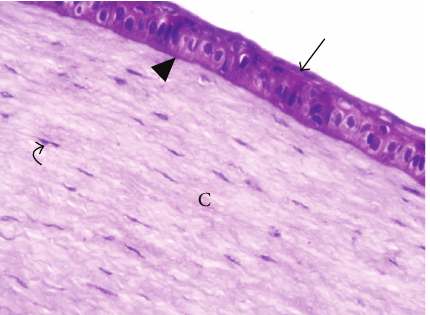
Figure 6: A photomicrograph of rabbit cornea group I, showing the layers of nonkeratinized squamous epithelium (arrow); basal layer, polygonal layers, and superficial layers. Notice the regular Bowman’s layer (arrow head). Corneal stroma (C) and stromal cells (curved arrow). H&E × 400.